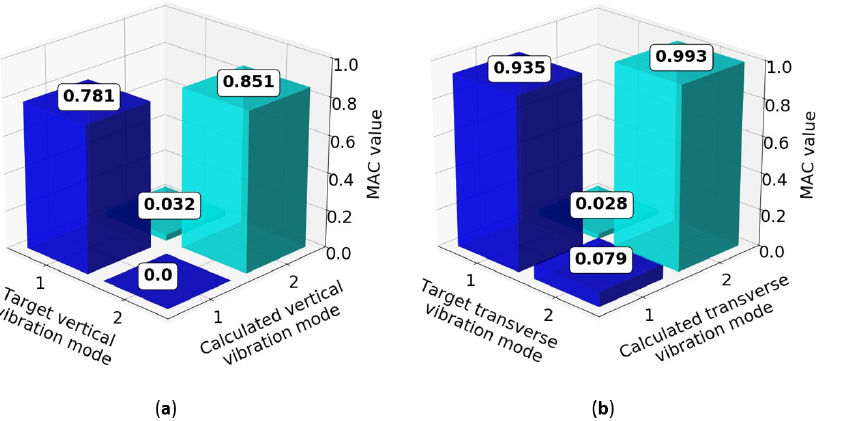
Figure 31. Modal assurance criteria for the mode shapes estimated of the structure: ( a ) Vertical mode correlation. ( b ) Transverse mode correlation.